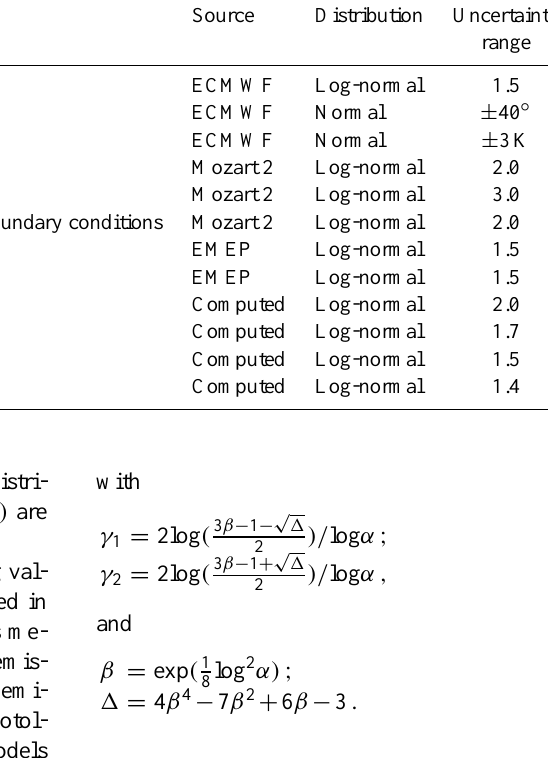
Table 2. Perturbation of input data. The last column is the parameter α that defines the uncertainty range. If the median value of a normally- distributed random variable ˆ p is p , the probability that ˆ p ∈ [ p − 2 α,p + 2 α ] is 0.95. If ˆ p is log-normally distributed, the probability that ˆ p ∈[ p/α,αp ] is 0.95. # Field Source